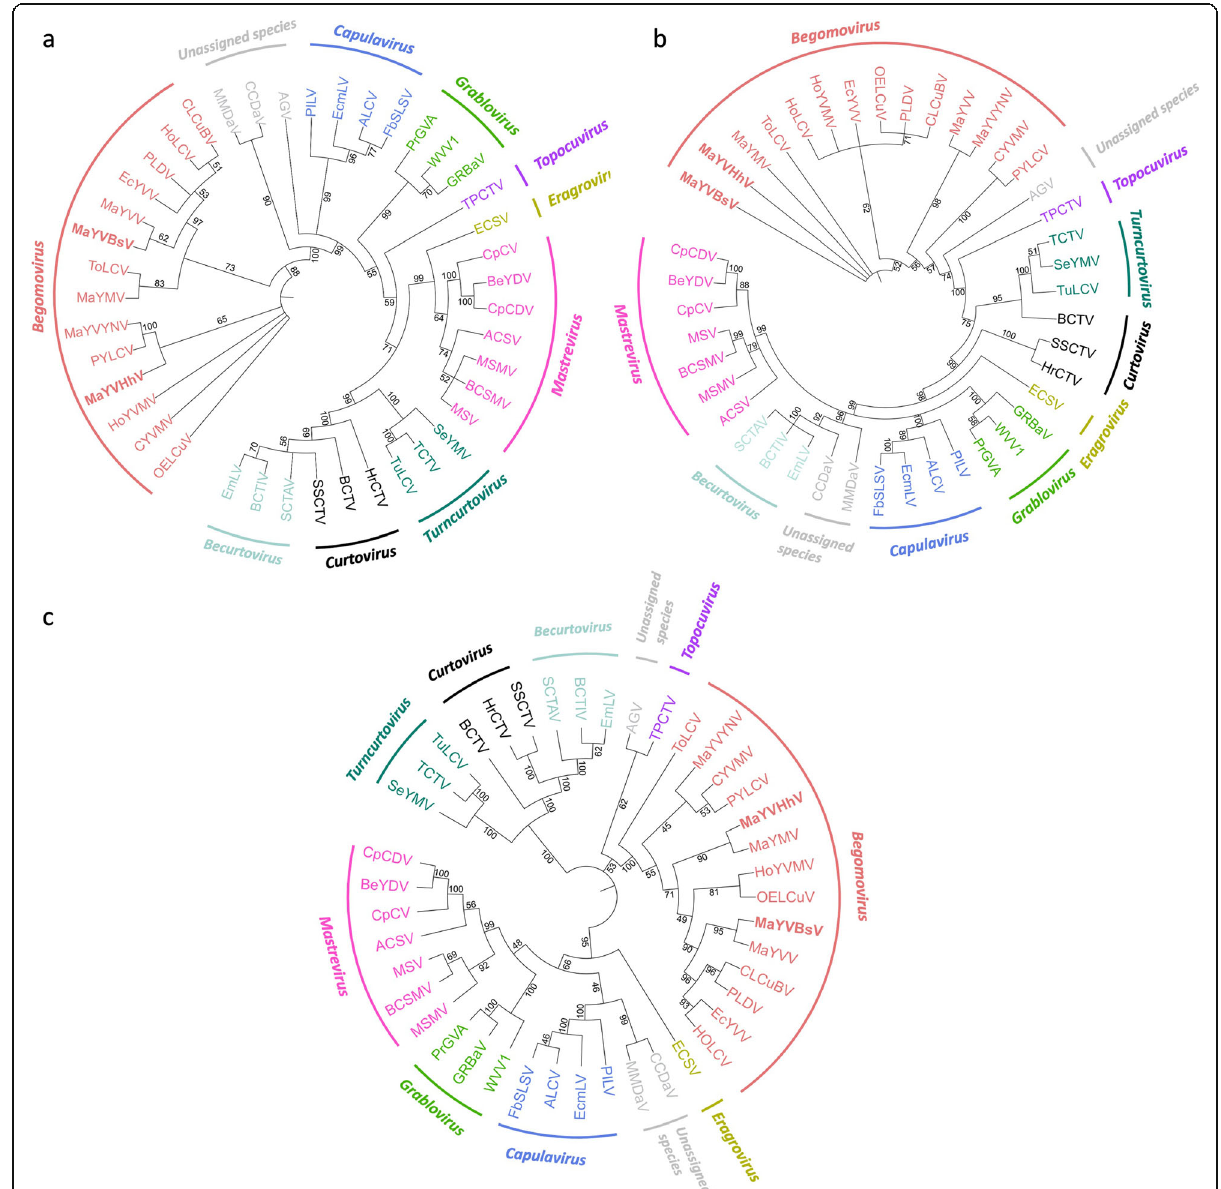
Fig. 3 Phylogenetic trees constructed based on the amino acid sequences of CP ( a ), Rep ( b ) or the complete viral DNA sequences ( c ) of members in the family Geminiviridae . Bootstrap values (%) for 1000 replicates are indicated. Virus names and their GenBank accession numbers are shown in Additional file 1: Table